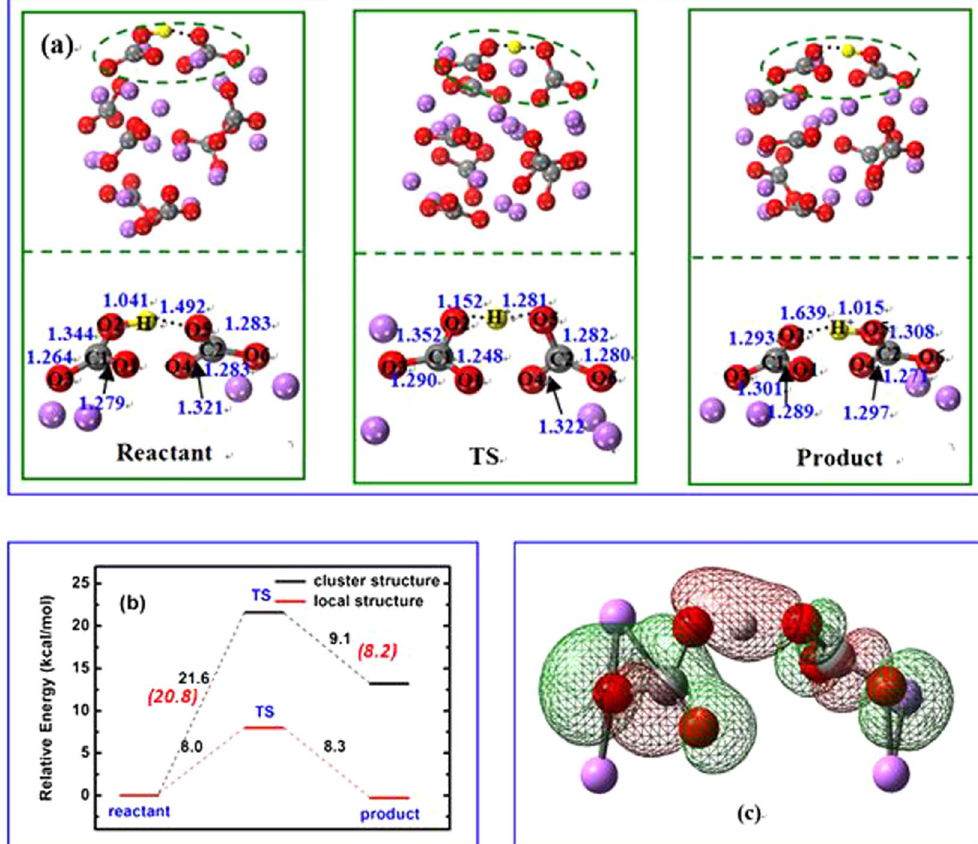
Figure 2. ( a ) Structures of reactant, transition state (TS), and product, the upper panel is cluster structure and the lower panel is local structure; ( b ) Relative energy for proton migration for inter-carbonate in the (Li 2 CO 3 ) 8 cluster and local structure, respectively; ( c ) Selected molecular orbital in TS for bonding between proton and carbonate. The proton, carbon, oxygen and lithium atoms are shown as yellow, gray, red, and purple respectively. (Distance in Å; Relative energy in